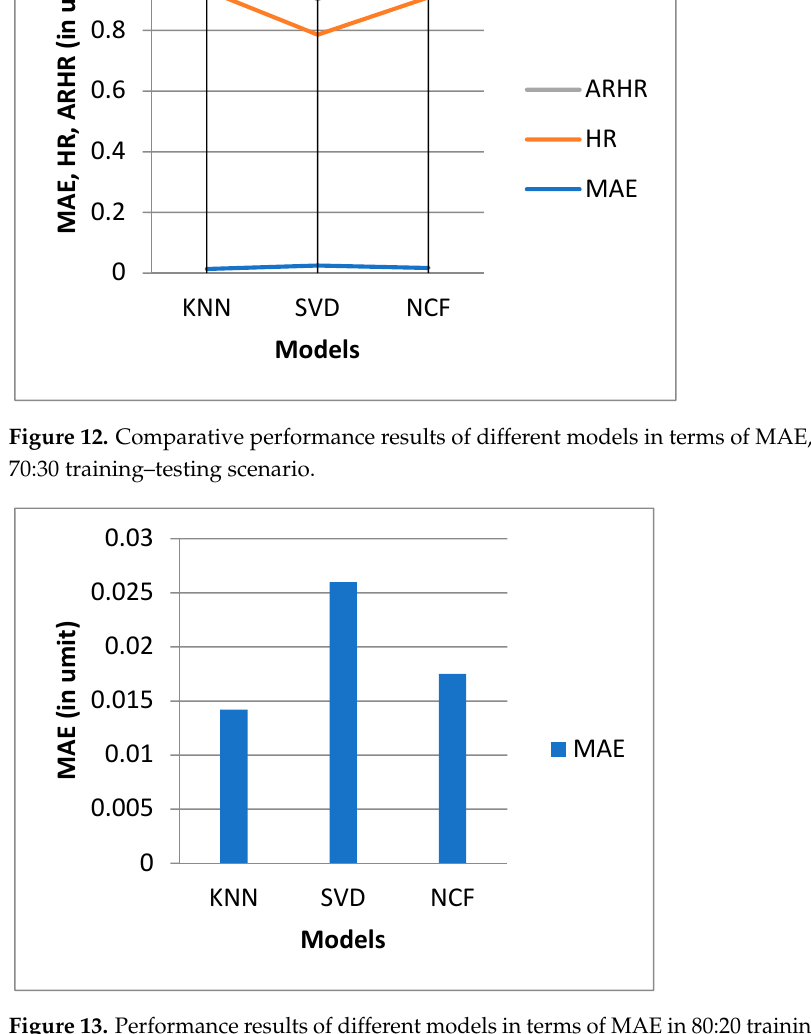
Figure 13. Performance results of different models in terms of MAE in 80:20 training–testing scenario.